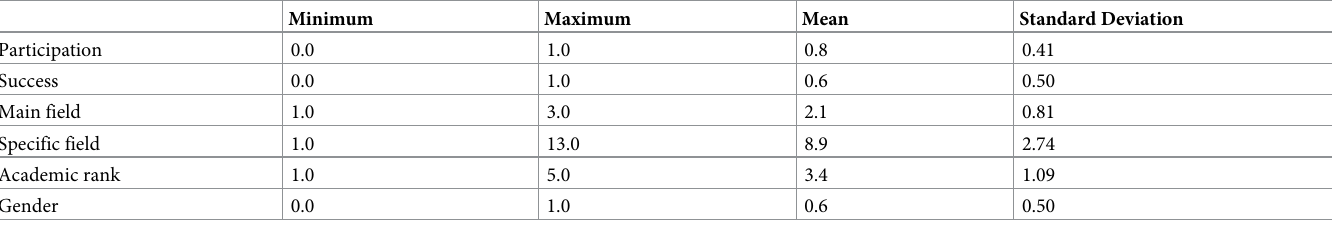
Table 6. Descriptive statistics of the variables included in the logistic model estimation.